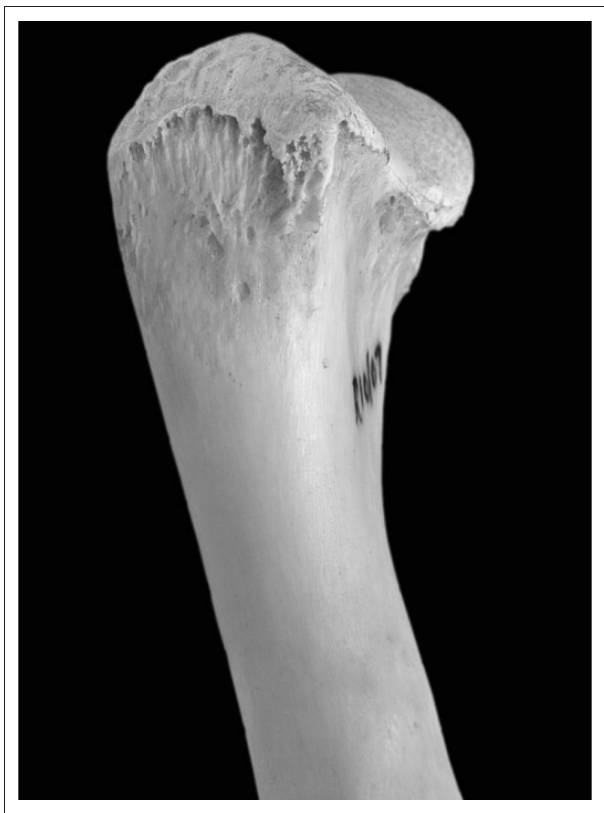
FIGURE 7: Humerus of an adult Nile crocodile, case 4: Severe loss of cortical substance around the distal articular surface of the humerus.